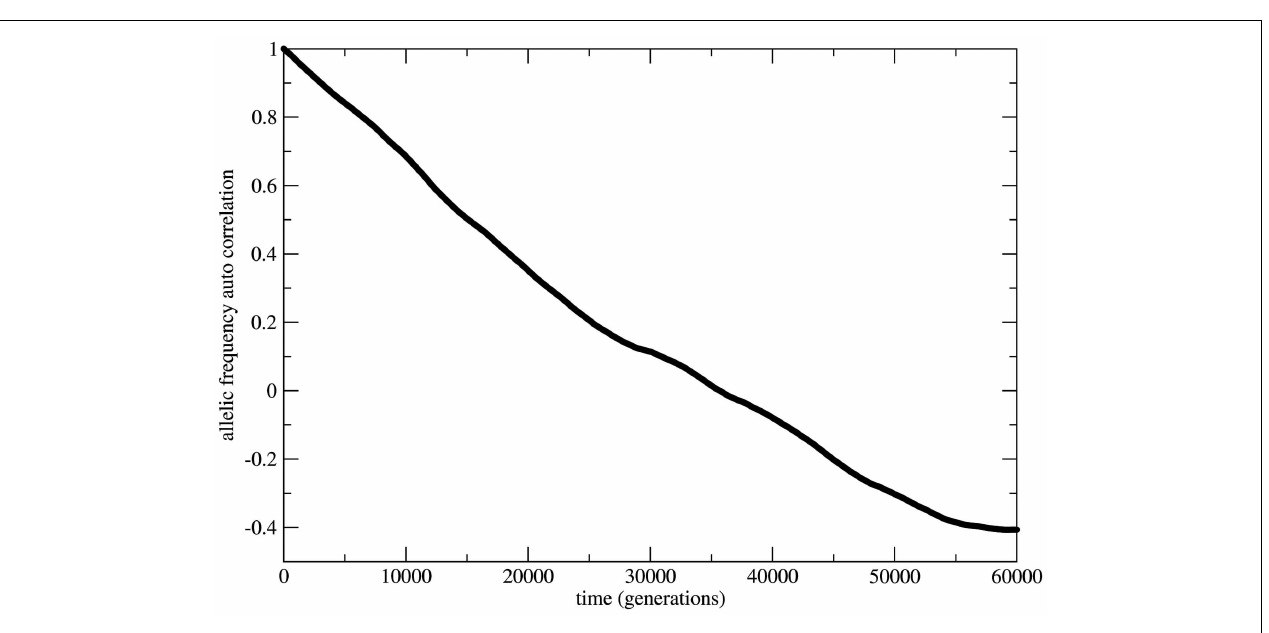
history of 3.0 × 10 5 generations.The auto-correlation function shows that the genetic system does not reach an equilibrium state till at least 60,000 generations.